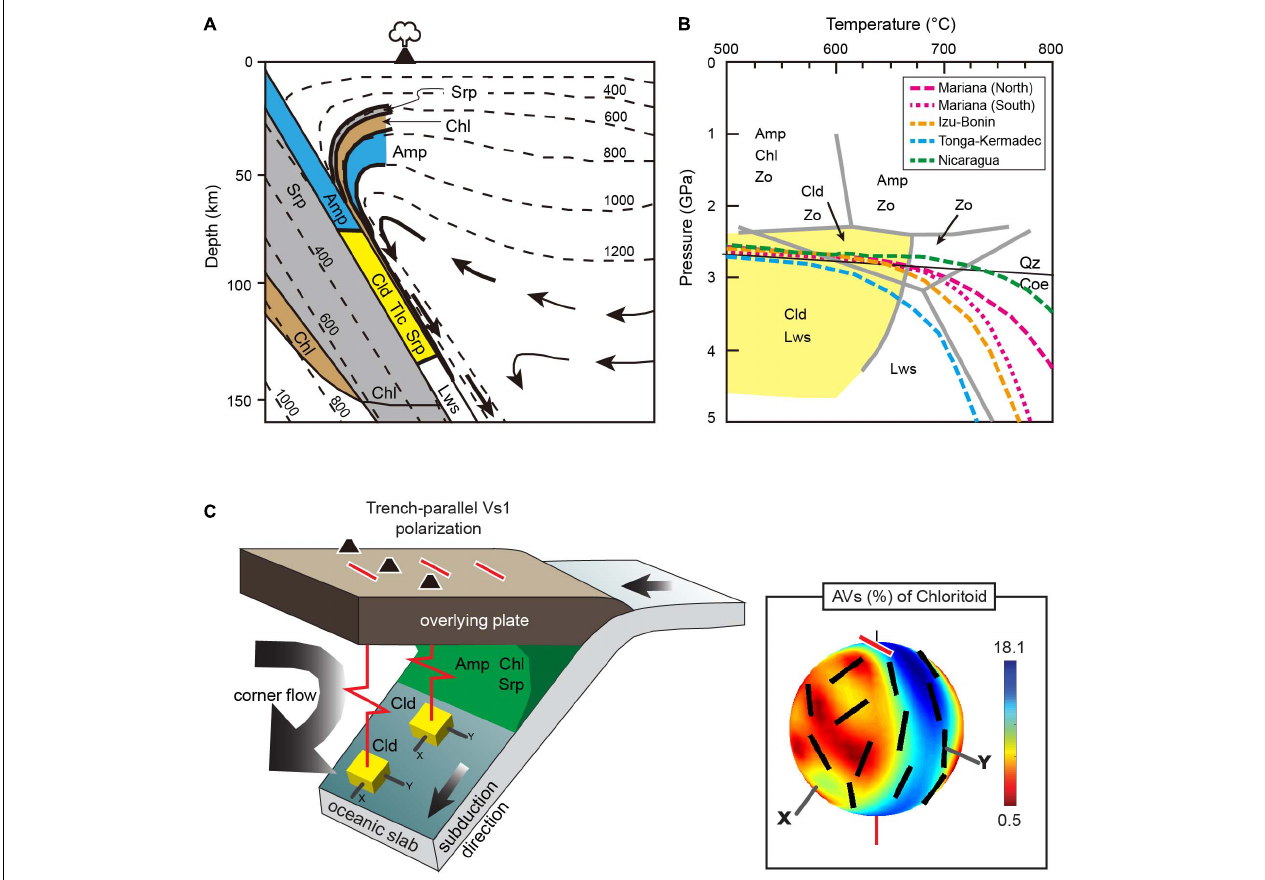
FIGURE 7 | (A) Schematic diagram illustrating a subducting slab with a dipping angle of 60 ◦ . Also shown are the thermodynamic stability fields of hydrous phases in the hydrated peridotitic layer, overlying the oceanic crystal layer and the mantle wedge region (modified after Schmidt and Poli, 1998). Stippled lines are isotherms and arrows indicate flow lines in the mantle wedge. (B) Pressure-temperature stability fields of hydrous phases in hydrated MORB under subduction zone conditions (modified after Schmidt and Poli, 1998). Dashed lines are the P–T paths of the slab surface for the Mariana, Izu-Bonin, Tonga-Kermadec, and Nicaragua settings (Syracuse et al., 2010). Yellow shaded region indicates the stability field of chloritoid based on the pseudosection modeling conducted here ( Figure 6 and Supplementary Figures 3, 4 ) and also on previous estimates (Schmidt and Poli, 1998). (C) Schematic diagram of a subduction zone illustrates the influence of the chloritoid LPO on the seismic anisotropy in the subduction zone. The applied slab-dip is 60 ◦ (rotation around the axis parallel to the Y-direction; see section “Discussion”) and the lineation (X-direction) is assumed to be parallel to the subduction direction. Red bars represent the polarization direction of the fast S-wave. Inset figure shows shear wave anisotropy (AV S ) and the polarization directions of fast S-waves (red and black bars) going through the chloritoid aggregates (sample #15R). X and Z represent the lineation (flow direction) and the direction perpendicular to the foliation (flow plane),